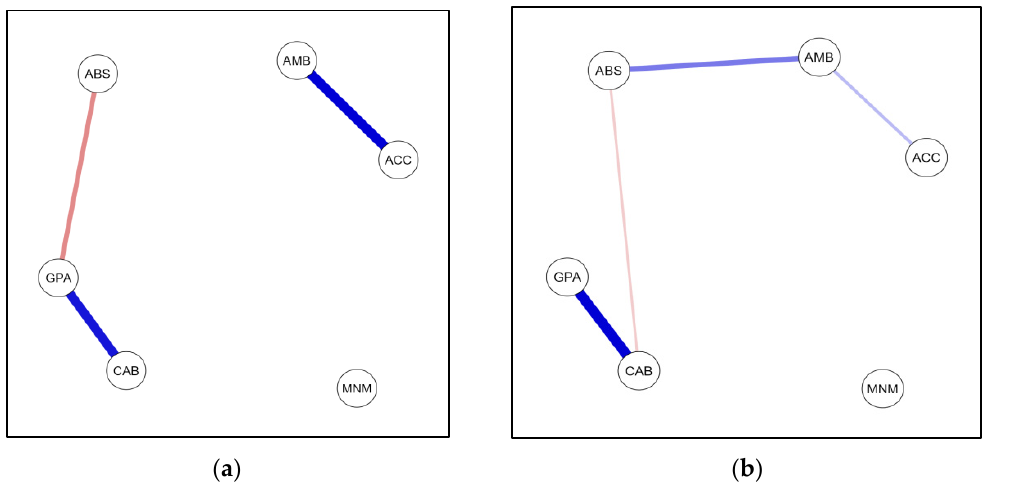
Figure 2. Graphical representation of the correlations between ISS subscales, STID-2 total score and GPA in male ( a ) and female ( b ) school students. Note : Blue lines are positive correlations, and red lines are negative correlations; line thickness corresponds to the value of the correlation coefficient. ACC is Acceptance , AMB is Ambivalence , ABS is Absolutization , and MNM is Minimization ; CAB is cognitive abilities (total score of STID-2). (ICC ethnocentric subscale) has a trend towards a negative correlation ( p < .10) with GPA in male students and a negative correlation with cognitive abilities (STID-2 total score) in